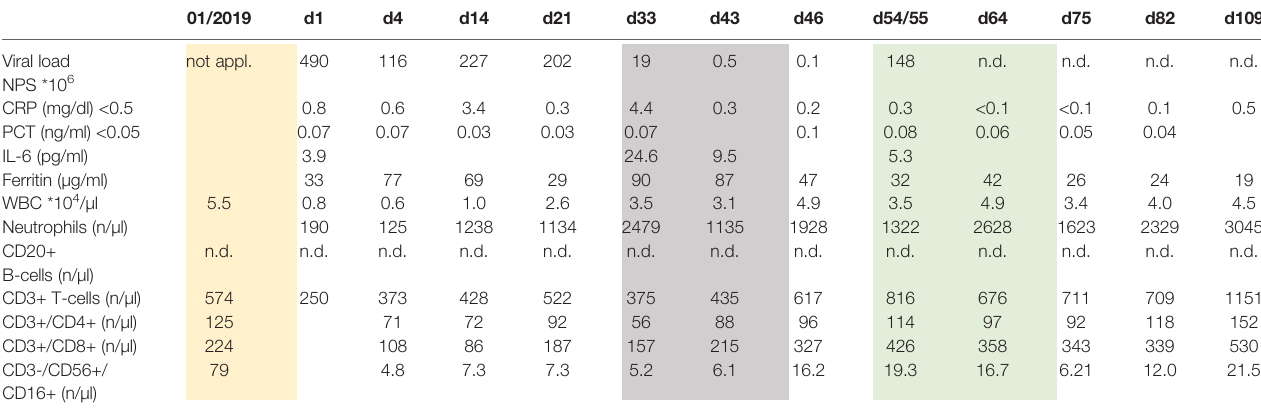
TABLE 1 | Laboratory and virological fi ndings; n.d., not detected; NPS, nasopharyngeal swab; CRP, C-reactive protein; PCT, procalcitonin; WBC, white blood cell count (absolute numbers) and differentiation by FACS.